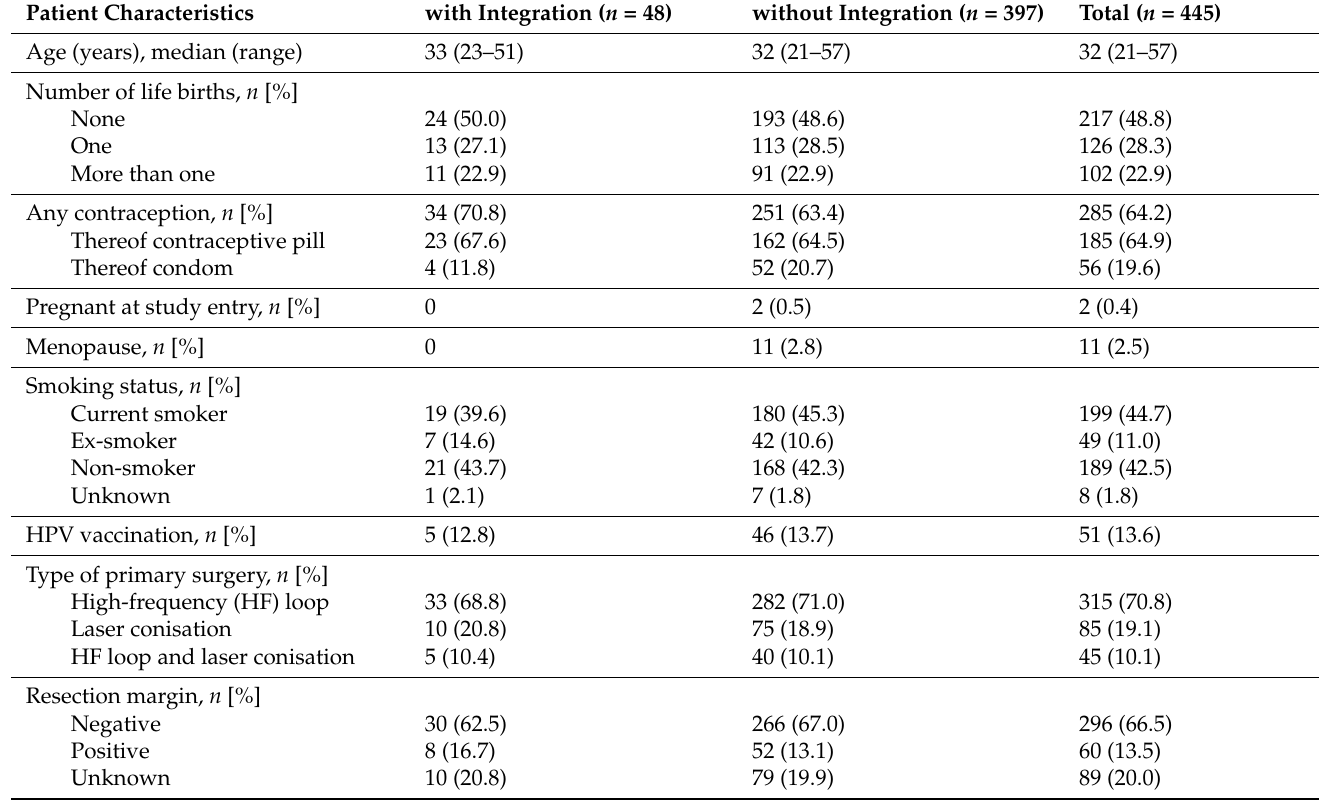
Table 1. Characteristics of patients according to the HPV16/18 DNA integration status (Step 1, analysis population). Patient